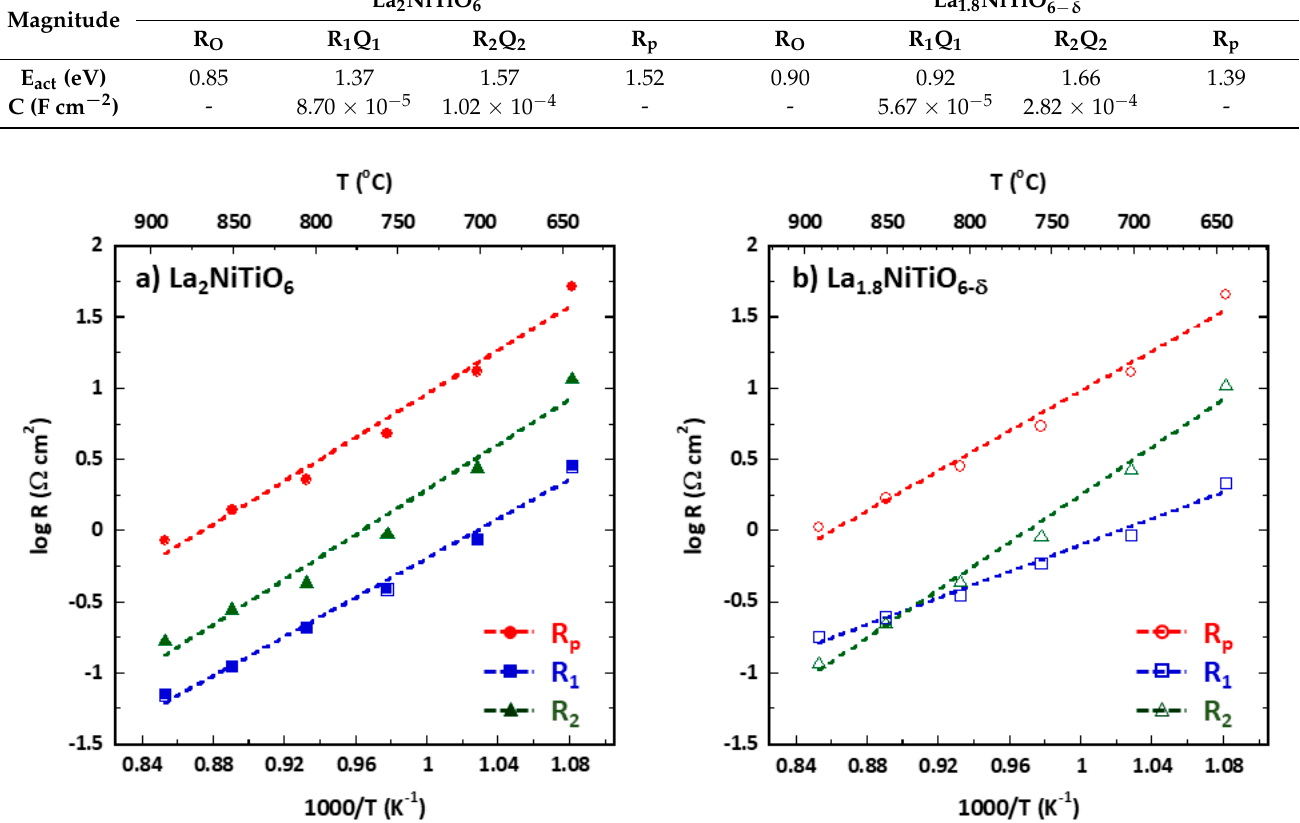
Figure 5. Arrhenius plot and corresponding fittings (dashed line) of La 2 − x NiTiO 6 −δ :YSZ/YSZ/La 2 − x NiTiO 6 −δ :YSZ symmetrical cells for ( a ) x = 0 (solid symbols) and ( b ) 0.2 (empty symbols) in the 1173 to 923 K temperature range. Rp (red circles), circuit resistance #1 (R 1 , blue squares), and #2 (R 2 , green triangles).